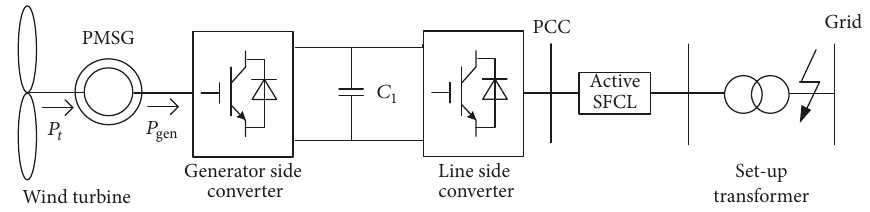
Figure 12: Schematic diagram of a PMSG-based wind turbine system integrated with the active SFCL.